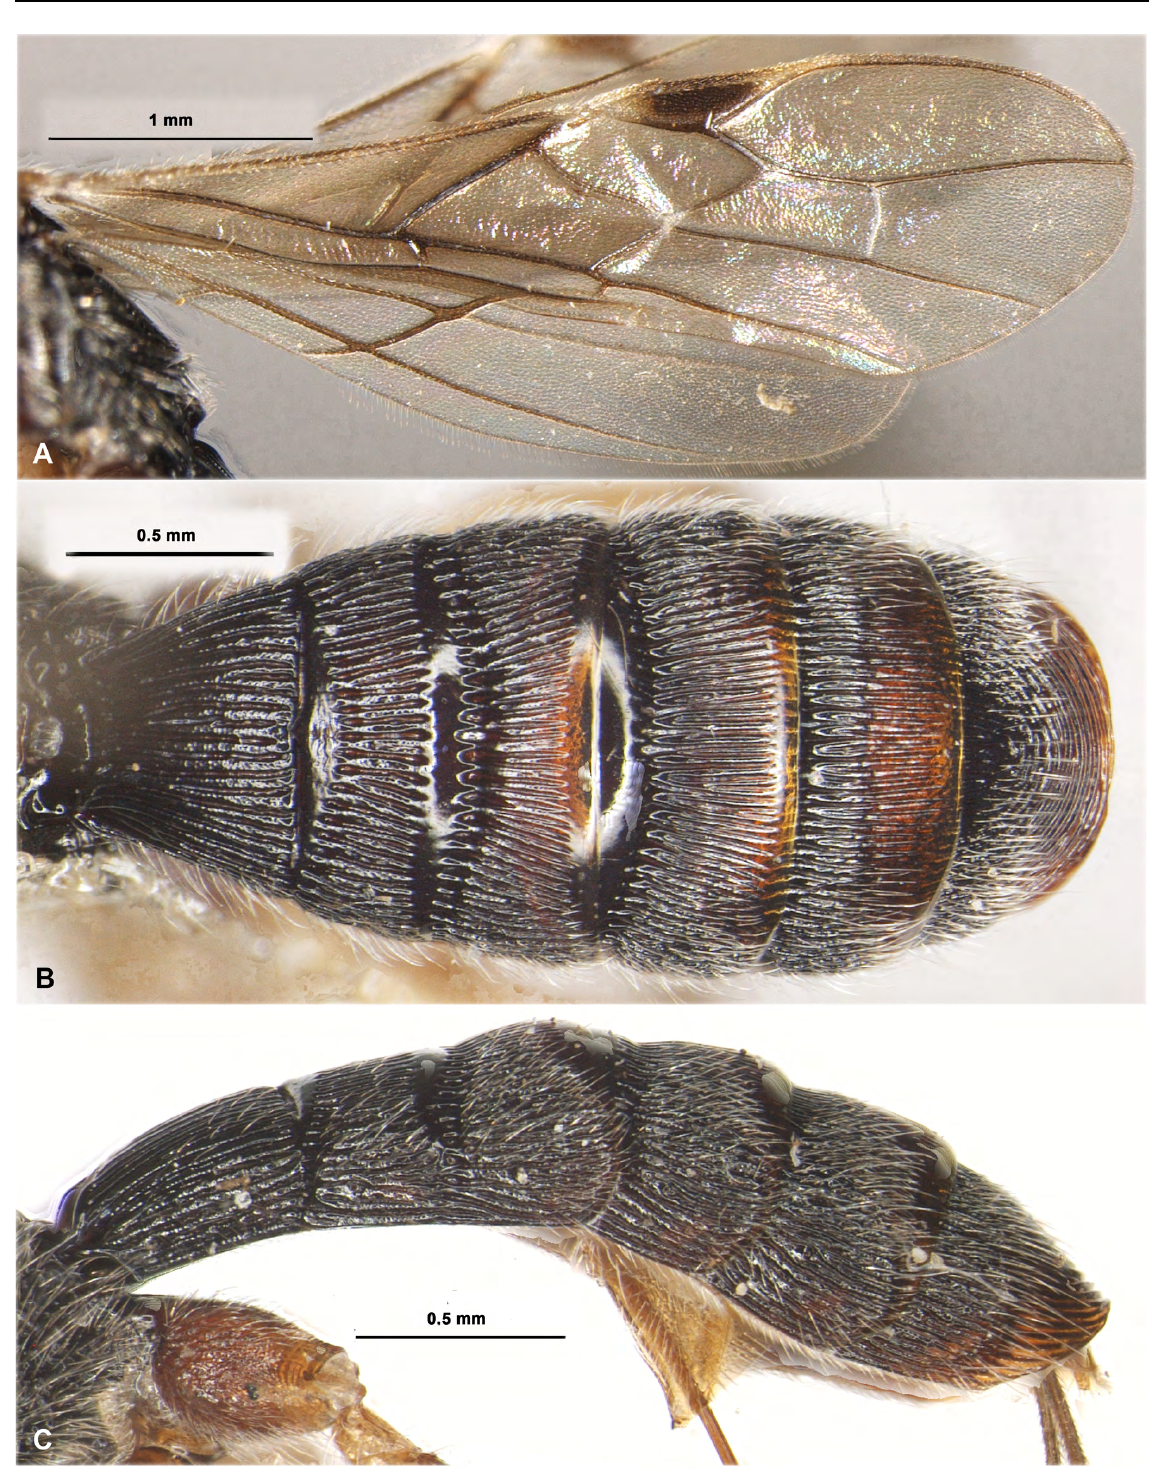
Fig. 25. Mimipodoryctes rubriceps (Cameron, 1909) , ♀, holotype of M. robustus Belokobylskij, 2000, ZISP. A . Wings. B . Metasoma, dorsal view. C . Metasoma, lateral